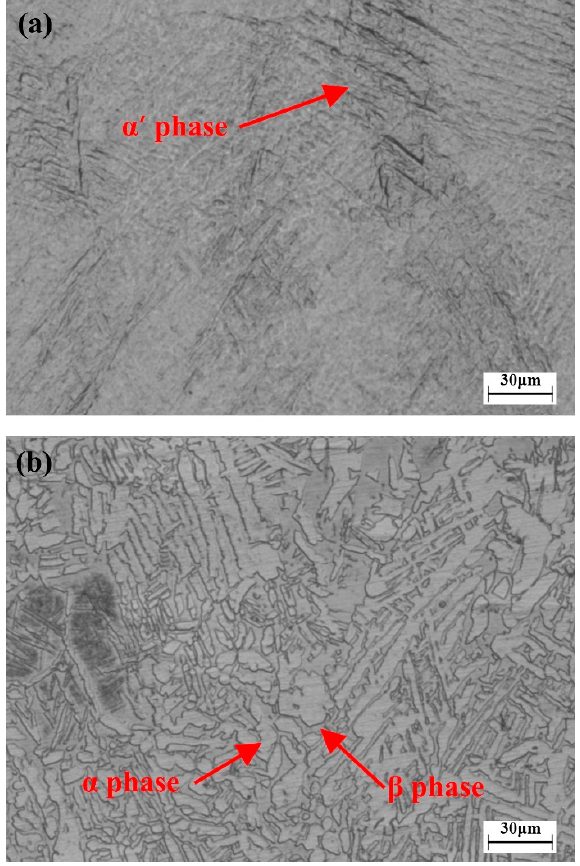
Figure 9. Surface micro-structure of Ti6Al4V alloy: ( a ) before heat treatment; ( b ) after heat treatment ( α phase is bright, β phase is dark).